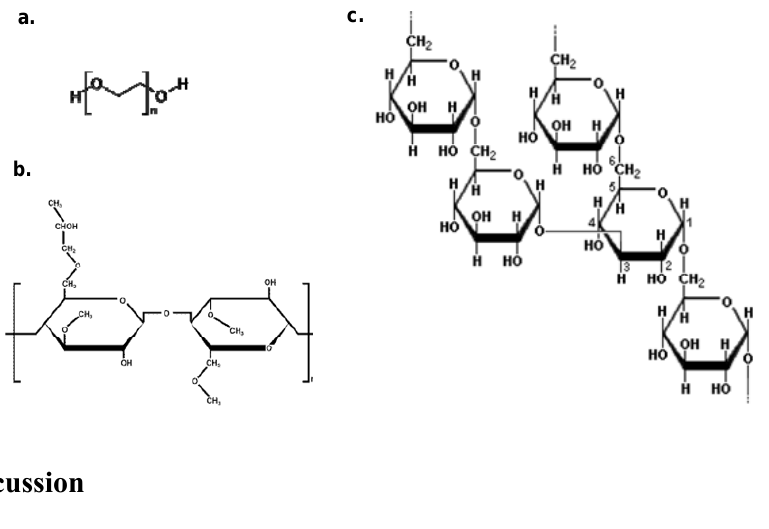
Figure 1. Schematic chemical structures for: (a) PEO, (b) HPMC and (c)